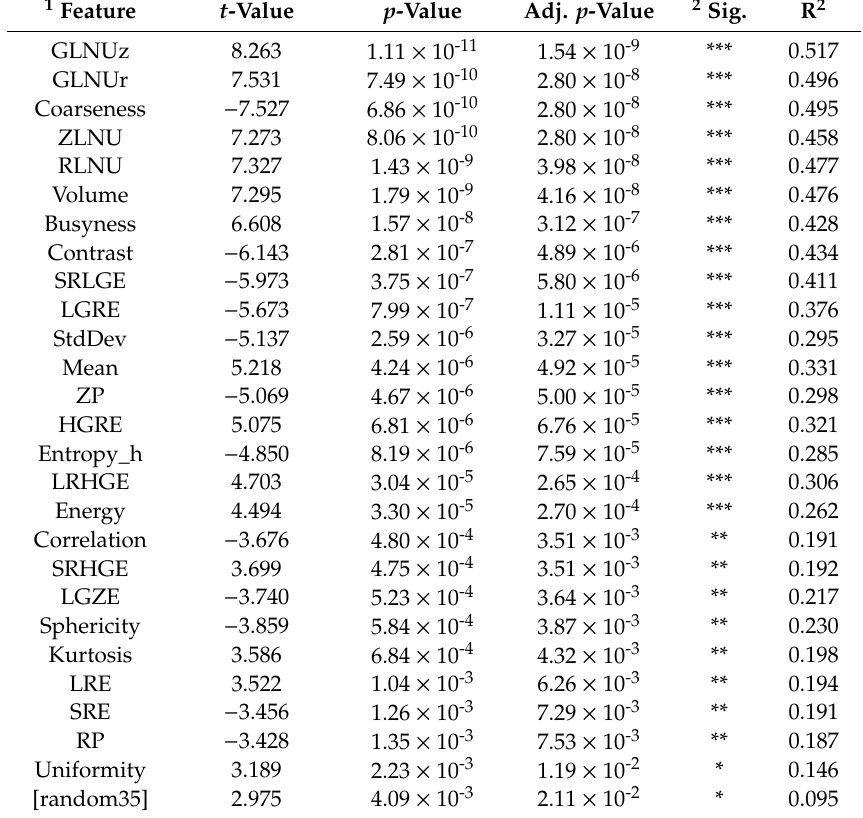
Table 2. Comparison of radiomic features to log(ctDNA maf ) without controlling for lesion